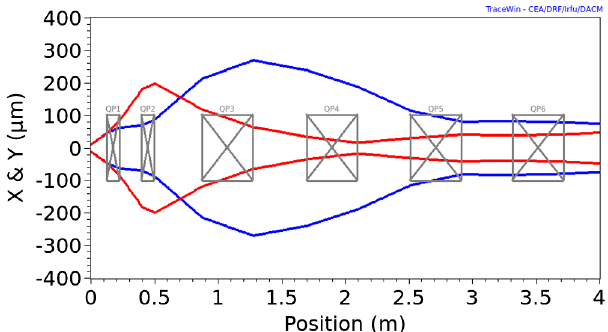
FIG. 8. 3-rms envelopes of the 5 GeV beam in the transfer line from the plasma exit to the undulator entrance (blue, horizontal; red, vertical).